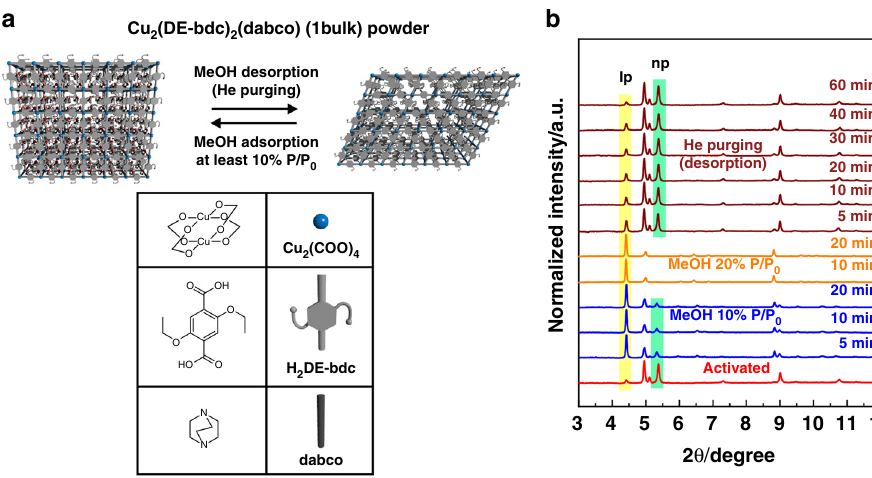
Fig. 2 Structural responsiveness of 1bulk upon methanol sorption. a Schematic representation of the breathing transformation of 1bulk upon methanol sorption and the representations of its structural components; b In-situ monitoring of GIXRD patterns (X-ray wavelength of 0.827 Å) during methanol sorption at 25 °C. The structural change from the activated, np form to the solvated, lp form is initiated by adsorption of 10% P / P 0 methanol and is complete after adsorption of at least 20% P / P 0 . Desorption of methanol by purging with dry He gas fl ow regains the activated, np form, which indicates the